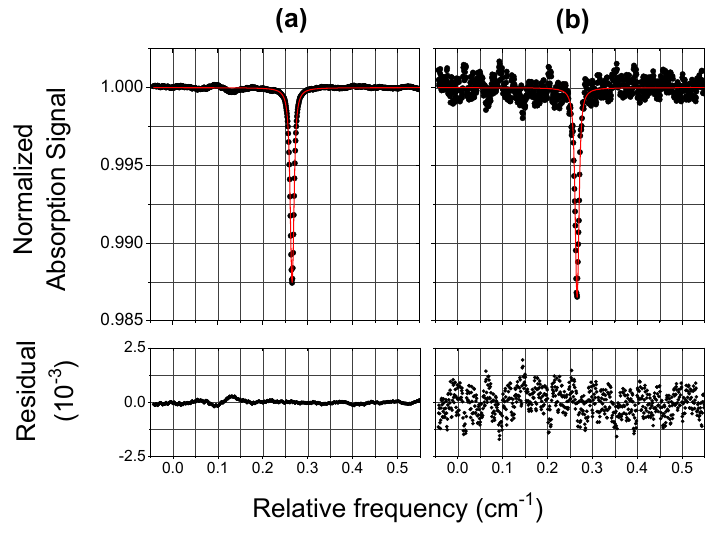
Figure 7. Normalized absorption spectra of a 125 ppbV CO mixture (scatter) and Voigt fit results (red line). The residual of the fitting procedure is shown in the bottom graph. The acquisition time is 1 s. The measurement was carried out at a pressure of 70 mbar and at a temperature of 295 K. The effect of the PZT in the multipass cell is also shown: ( a ) PZT on; ( b ) PZT